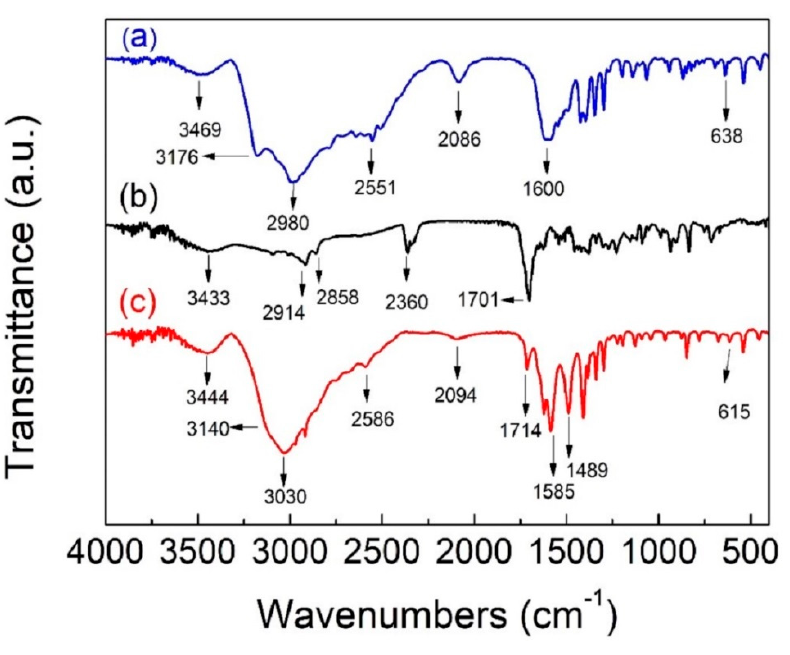
Figure 4. Fourier-transform IR (FTIR) spectra of ( a ) cysteine, ( b ) ZnPP, and ( c ) ZnPP/cys.